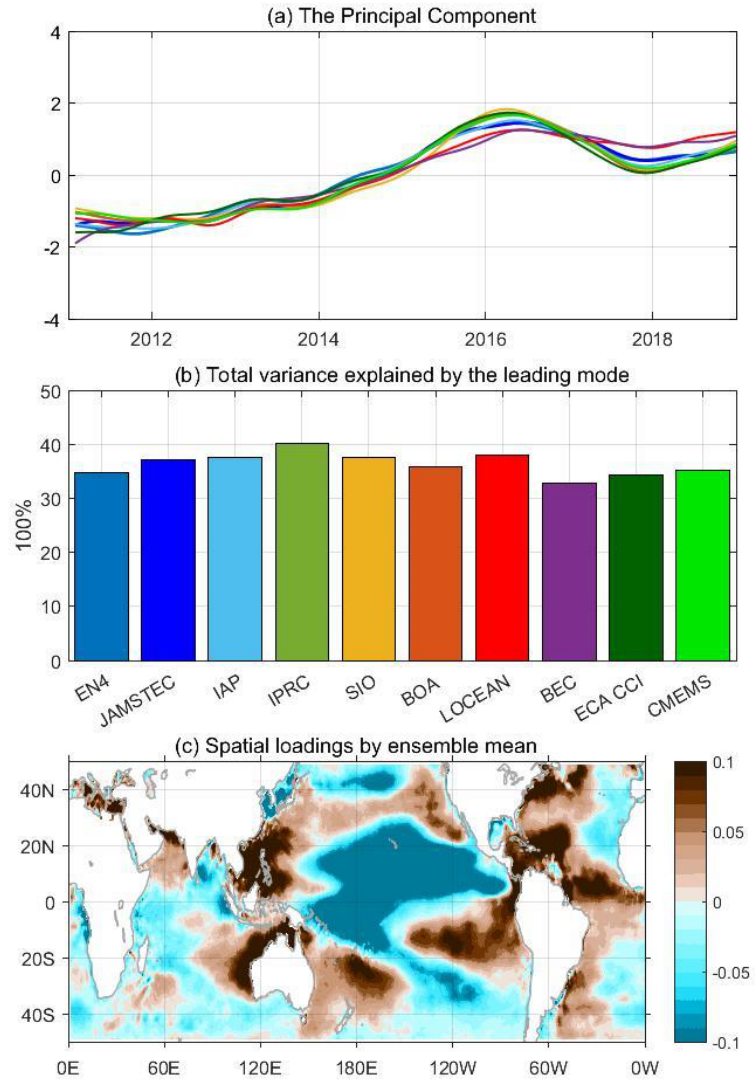
Figure 13. ( a ) The principal components for the interannual SSS time series and ( b ) their contributions to the total variability in the interannual SSS signal. The dark blue line/bar in ( a ) and ( b ) denotes EN4, blue represents JAMSTEC, light blue represents IAP, green represents IPRC, yellow represents SIO, orange represents BOA, red represents LOCEAN, purple represents BEC, dark green denotes ECA CCI and bright green denotes CMEMS. ( c ) The ensemble mean for the spatial loadings of the first EOF modes.